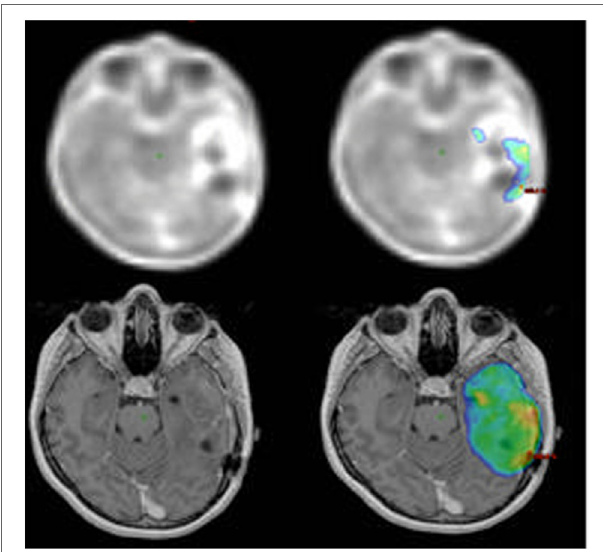
FigUre 1 | Increased 18F-FET uptake in the PET imaging (upper left) and 100% isodose map (top right). T1-gad MRI image (bottom left) and 95% isodose map (bottom right).